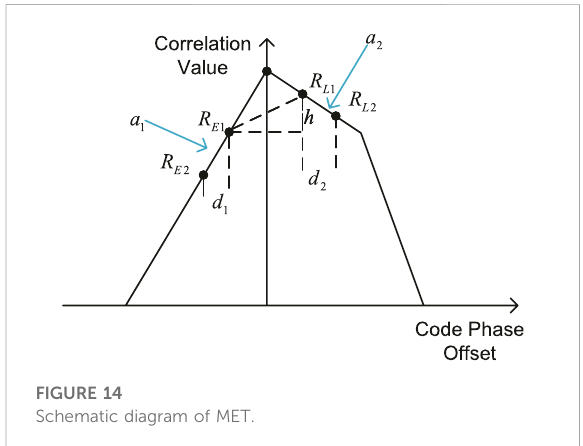
FIGURE 14 Schematic diagram of